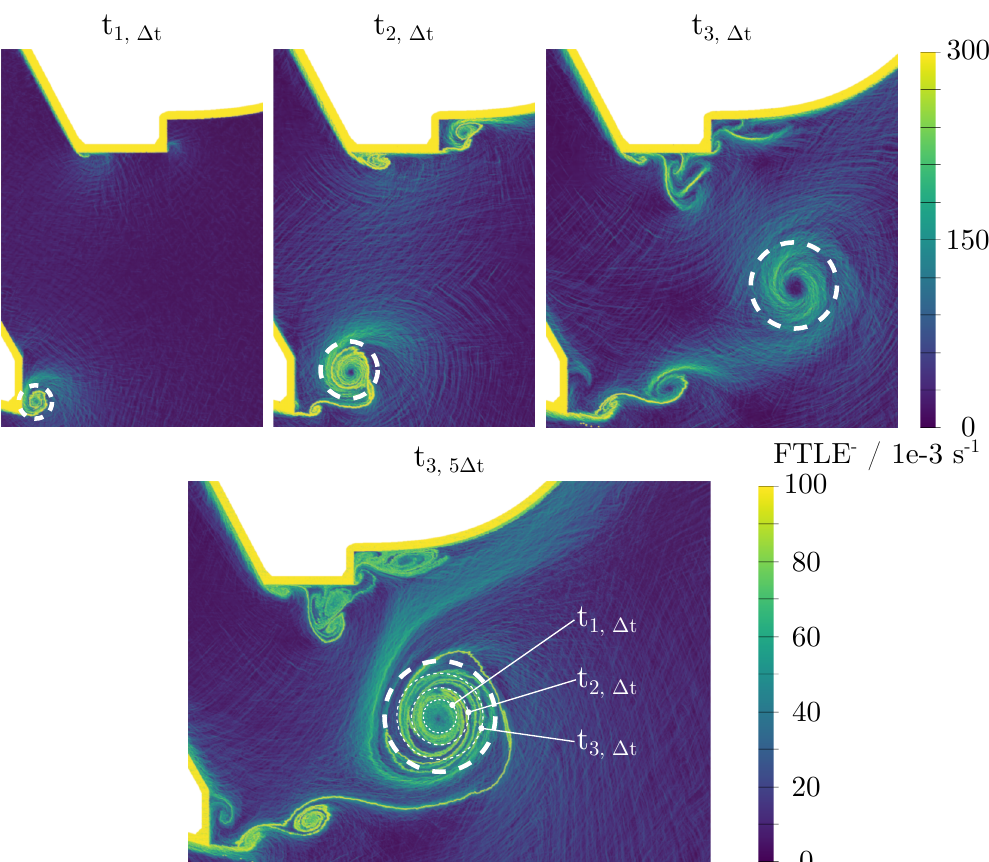
Figure 8. FTLE − fields—influence of the integration time.